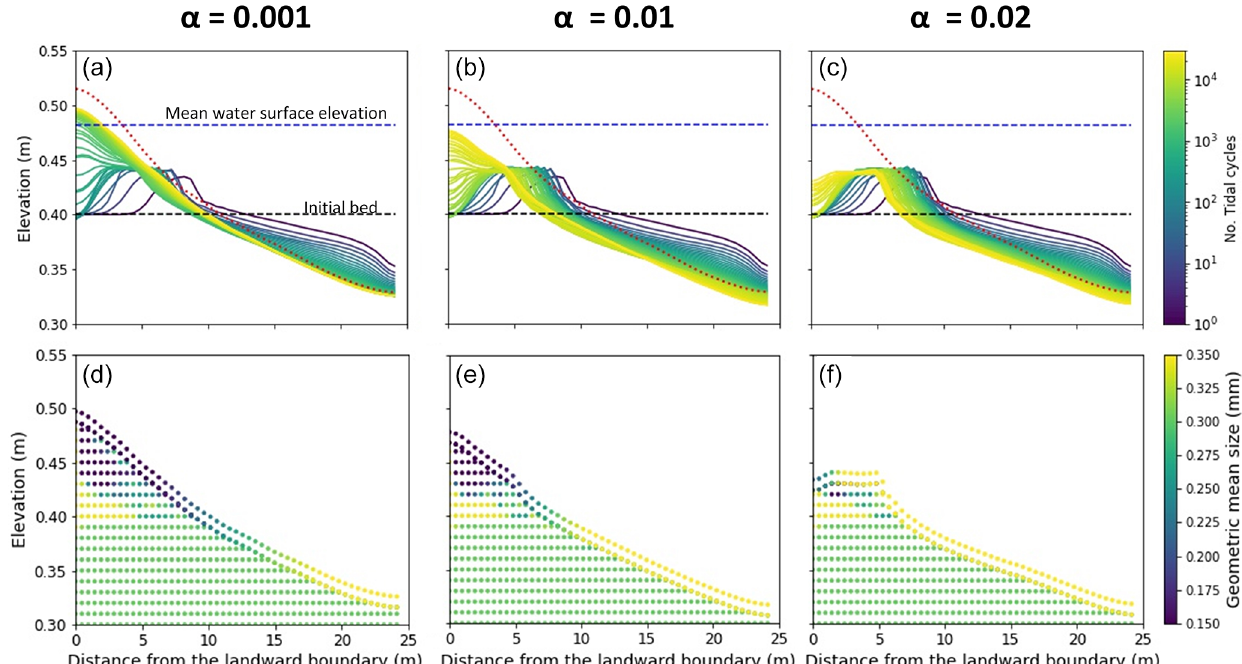
Figure 8. Effect of the bio-cohesivity parameter ( α ) that relates the biofilm with critical shear stress for erosion. Bed evolution profile (a, b, c) and final stratigraphy of the deposit after 30000 tidal cycles (d, e, f) in the case of α = 0.001 (left), the reference case ( α = 0.01, centre) and α = 0.02 (right). The bed profiles are compared with the clean sediment final bed elevation at equilibrium (dashed red lines). The dashed blue and green lines represent the initial water surface elevation and the initial bed profile, respectively. The initial geometric mean size of the bed is